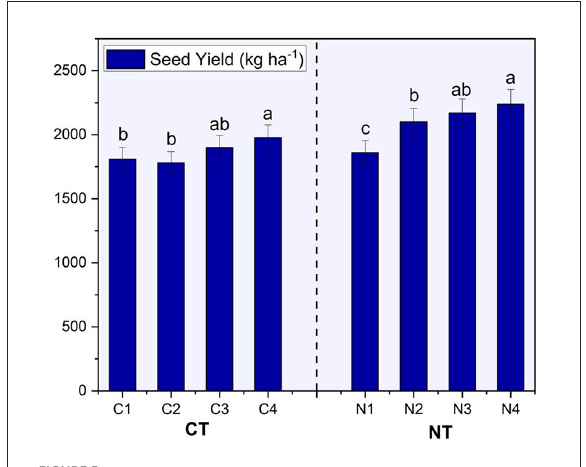
FIGURE5 Interactive effect of intercropping, mulching, and different tillage systems on cotton seed yield. Other letters above graph bars indicate significant differences p ≤